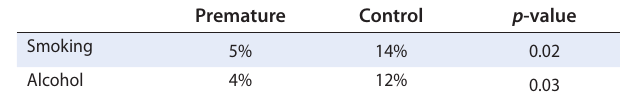
Table 1: Comparison of smoking and alcohol use during pregnancy of the premature and control groups Premature